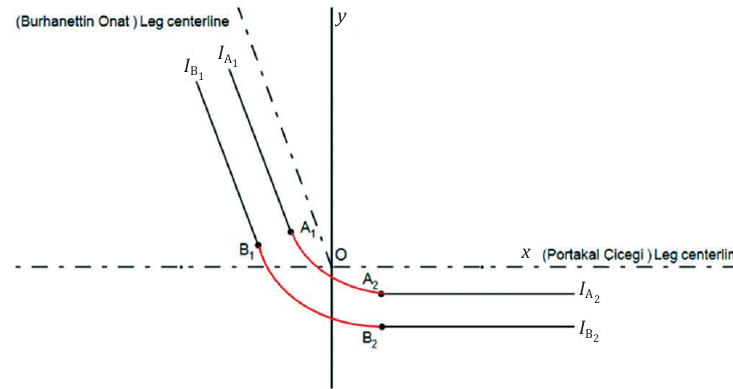
Figure 10. Drawing of the direct connection road in the proposed roundabout (by G.